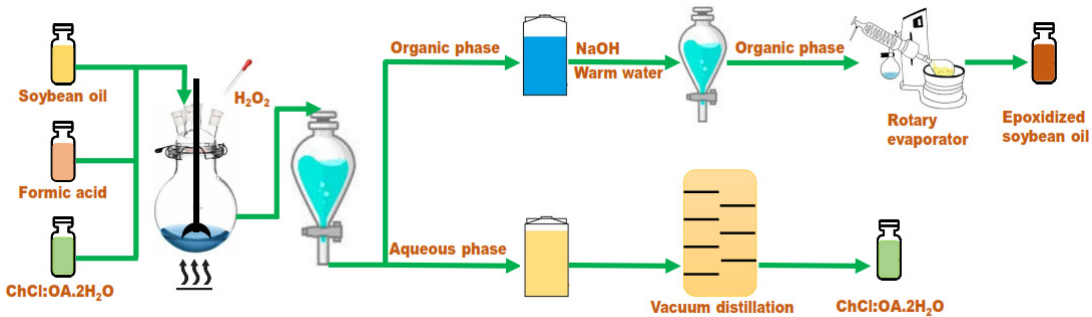
Figure 15. The flowchart for production of epoxidized soybean oil (ESBO).